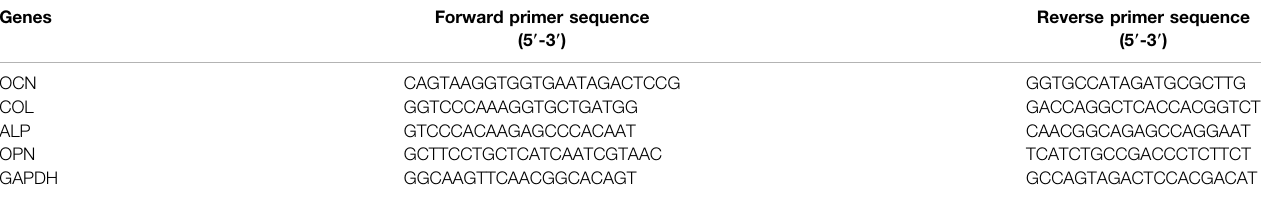
TABLE 1 | Primer sequences of bone-related genes.